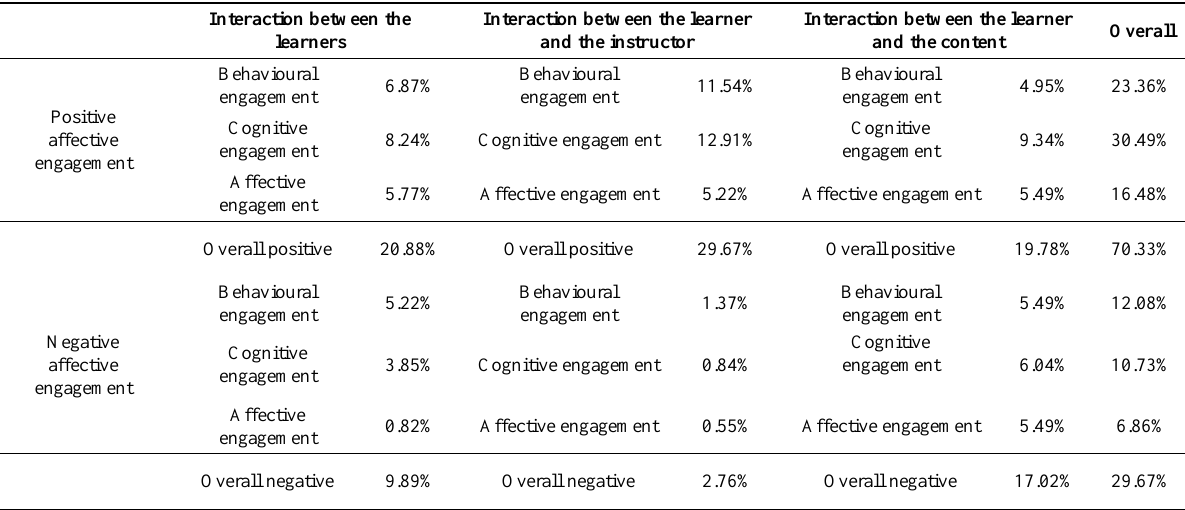
Table 11. Percentages of positive and negative affective engagement in forums (N= 364